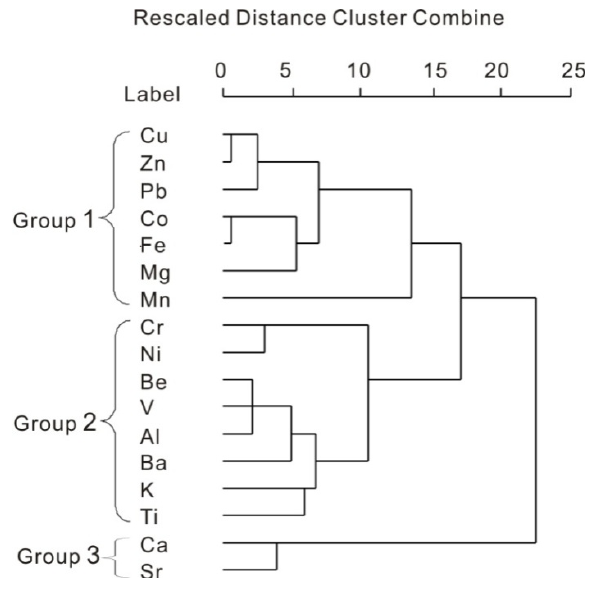
Figure 2. Dendrograms produced by hierarchical clustering of trace metals in the sediments from selected lakes.